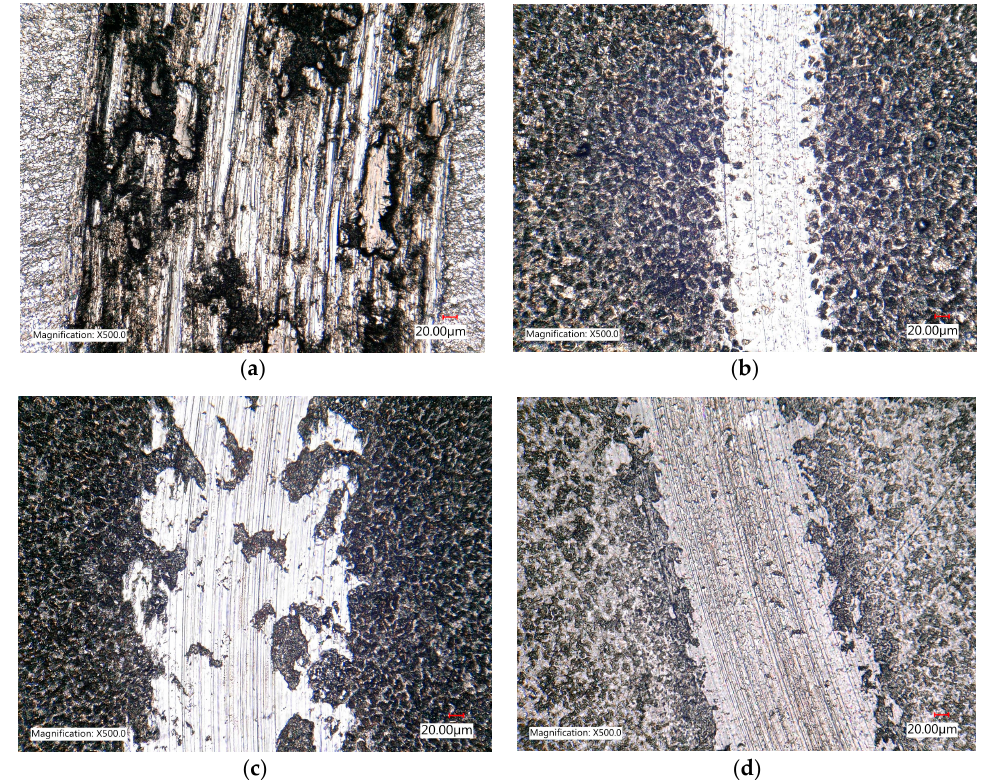
Figure 10. Wear tracks on the different steel surfaces, at 500× magnification for a sliding distance of 60 m on: ( a ) untreated steel, ( b ) oxy-nitrided with 20 wt% urea, ( c ) oxy-nitrided with 30 wt% urea and ( d ) oxy-nitrided with 40 wt% urea.